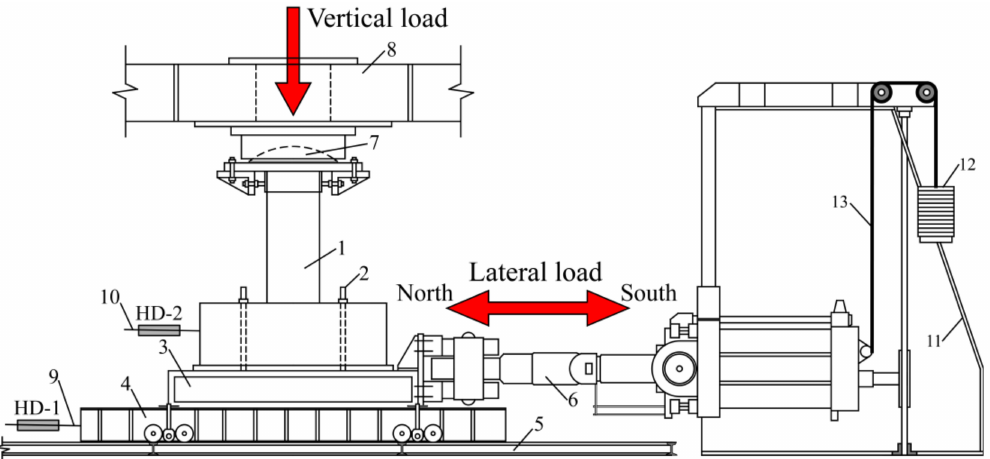
Figure 4. Test setup. Note: 1 . Specimen; 2 . M48 bolts; 3 . Test pedestal; 4 . Test car; 5 . Rail; 6 .